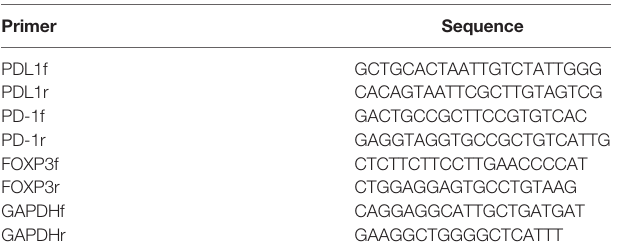
TABLE 1 | Primer sequence. Primer Sequence